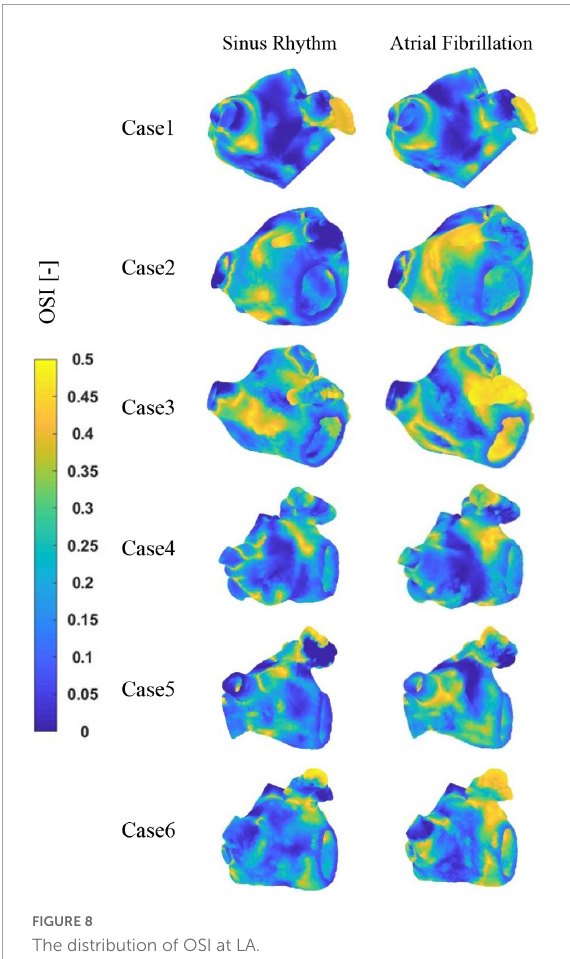
FIGURE9 The distribution of RRT at